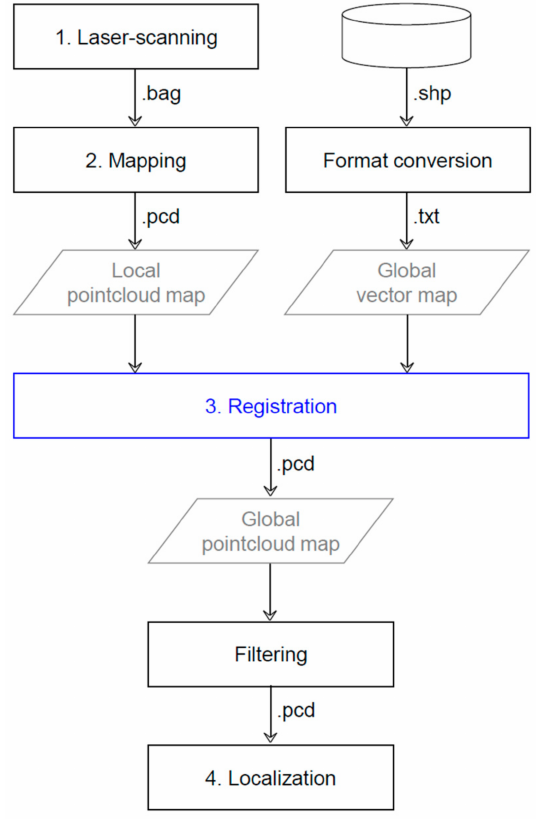
Figure 4. High-level flowchart outlining key stages in pointcloud map generation. Table 7. Four stages of pointcloud map